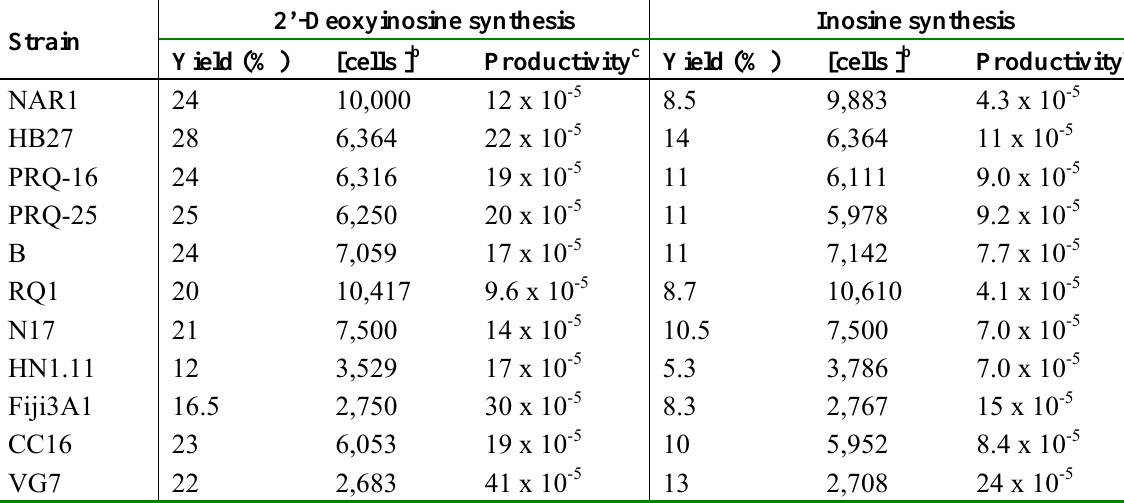
Table 1. Yield and productivity values in the reaction dUrd or Urd + hypoxanthine, using different T. thermophilus strains a .